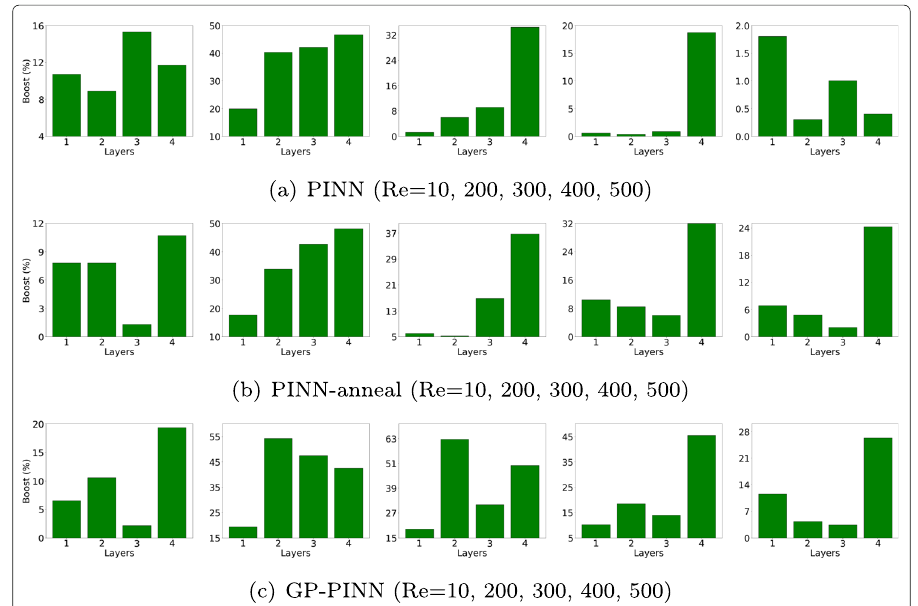
Fig. 6 The effect of different number of transfer layers on the prediction accuracy of the Navier-Stokes